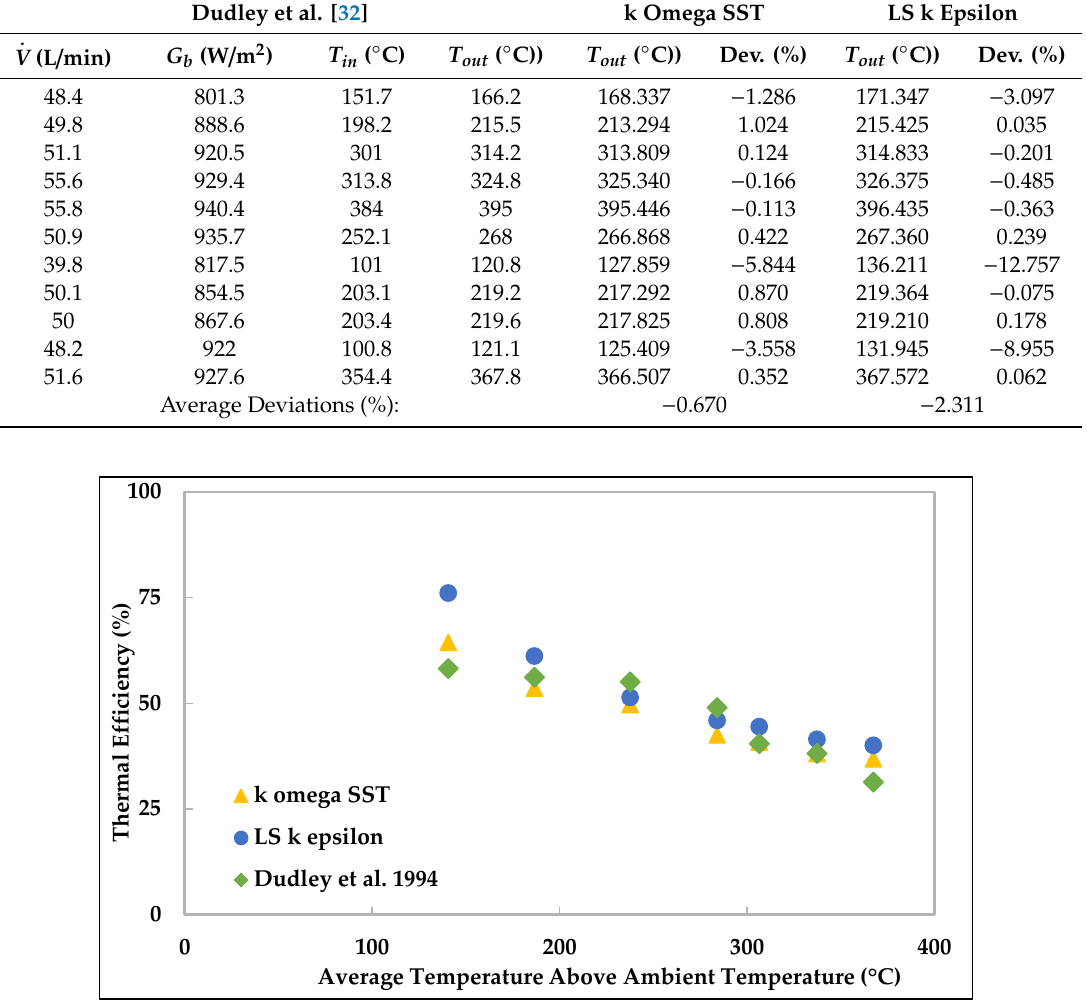
Figure 4. Validation of the present study with the thermal e ffi ciency data of Dudley et al. [24]. It can be seen from the Figure 4 that the k- ω SST turbulence model predicted the thermal e ffi ciency better than the LS k-epsilon model especially for the lower inlet temperature cases. The model was also validated for the Nu number of pure water moving inside the solar receiver with the experimental correlations of Petukhov [34] and Gnielinski [35] as shown in Figure 5a. Here it can again be observed that the LS k-epsilon model under predicted the Nu number compared to the k- ω SST model and the correlations. The last experimental correlation of Petukhov [34] for the friction factor was also used to validate the numerical results of the k- ω SST turbulence model only as shown in Figure 5b. This correlation is for a fully developed turbulent flow. As shown in the figure that the agreement between numerical results and experimental data is very good in all turbulent regimes. Form all the validation figures presented above, it can be deduced that the k- ω SST model is the better choice and was hence used for all the remaining